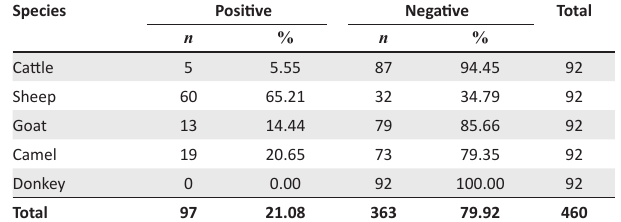
FIGURE 1: Map of Egypt showing the location of Qena, Luxor and Aswan governates, where the samples were collected. TABLE 1: Classification of animals according to geographical distribution, age, sex and breeding system.